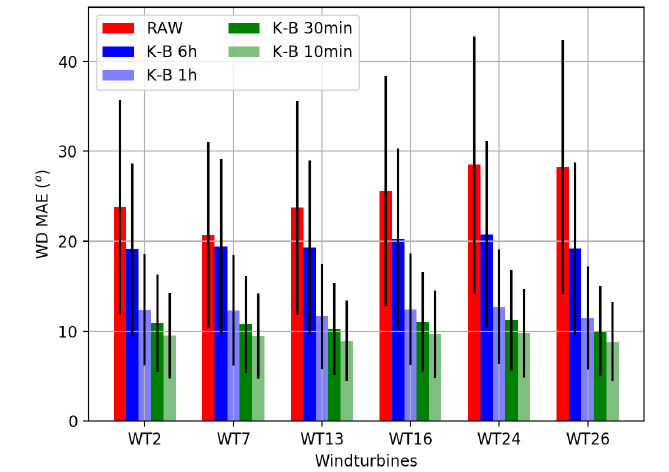
Figure 7. Barchart with annual WD MAE for all experiments and wind turbines analyzed. For each case, the standard deviation is represented by a black line ( σ ) on top of each